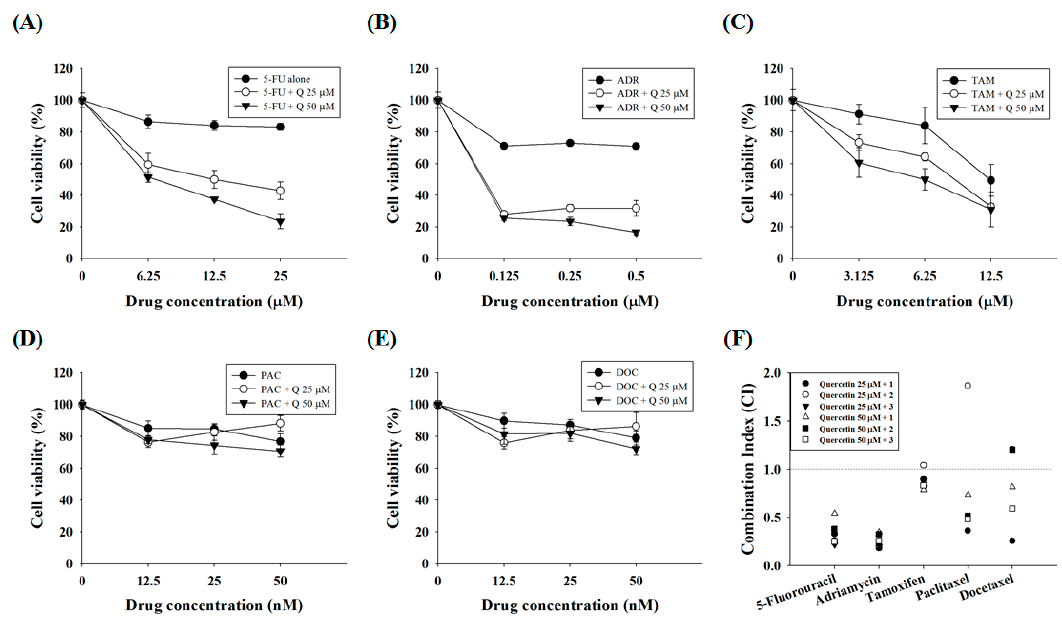
Figure 5. Quercetin synergizes the actions of standard chemotherapeutic drugs in AGS-cyr61 cells. AGS-cyr61 cells were treated with 25 and 50 µ M quercetin (Q) and the standard chemotherapeutic drugs ( A ) 5-FU; ( B ) ADR; ( C ) TAM; ( D ) PAC; and ( E ) DOC in AGS-cyr61 cells for 48 h. The MTT assay was used to measure cell viability; ( F ) Combination index (CI) value was calculated using the program CalcuSyn. CI values of <1, 1, and >1 were considered to indicate synergistic, additive, and antagonistic effects, respectively.